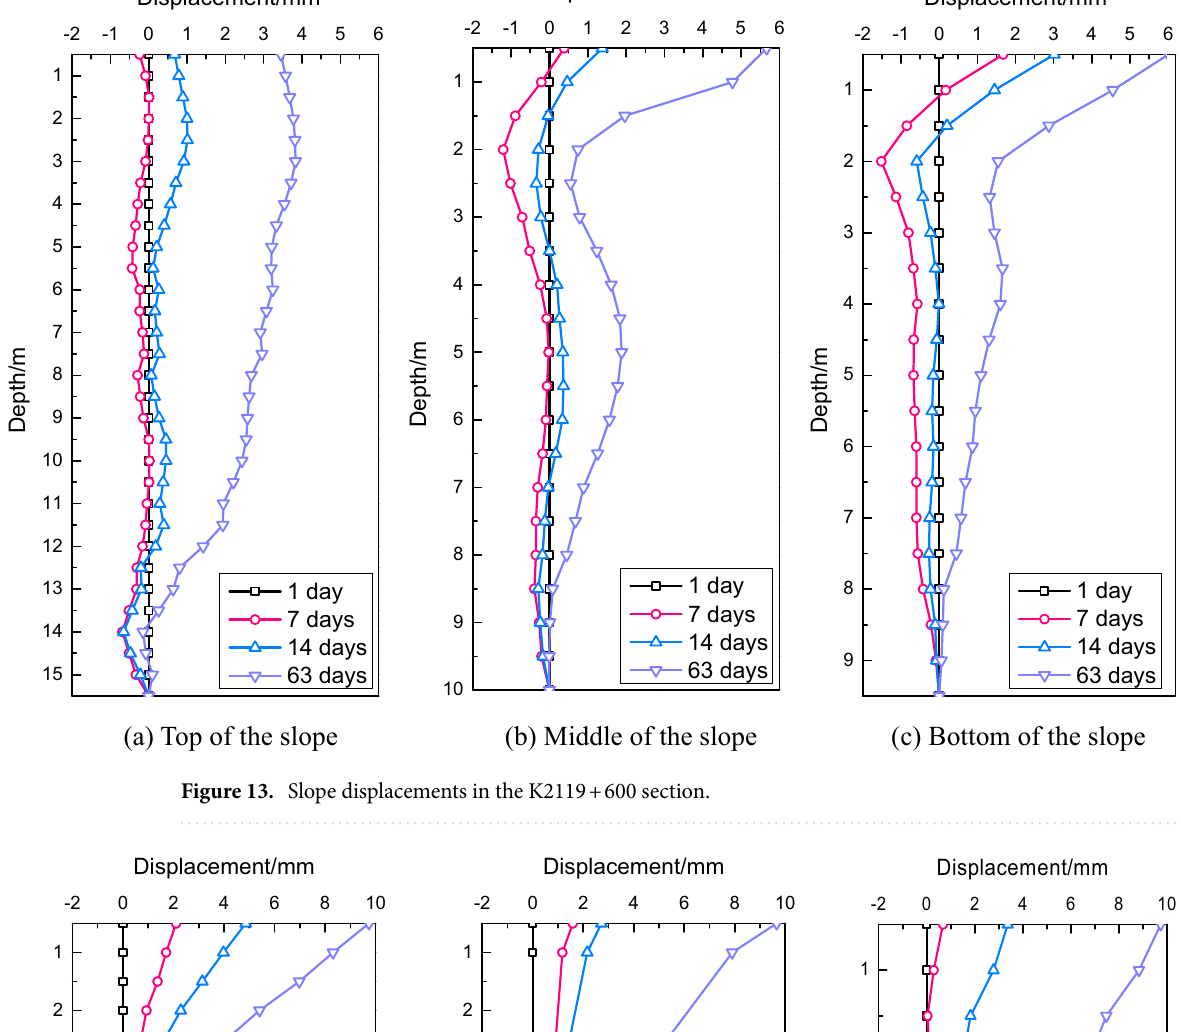
Figure 13. Slope displacements in the K2119 + 600 section.